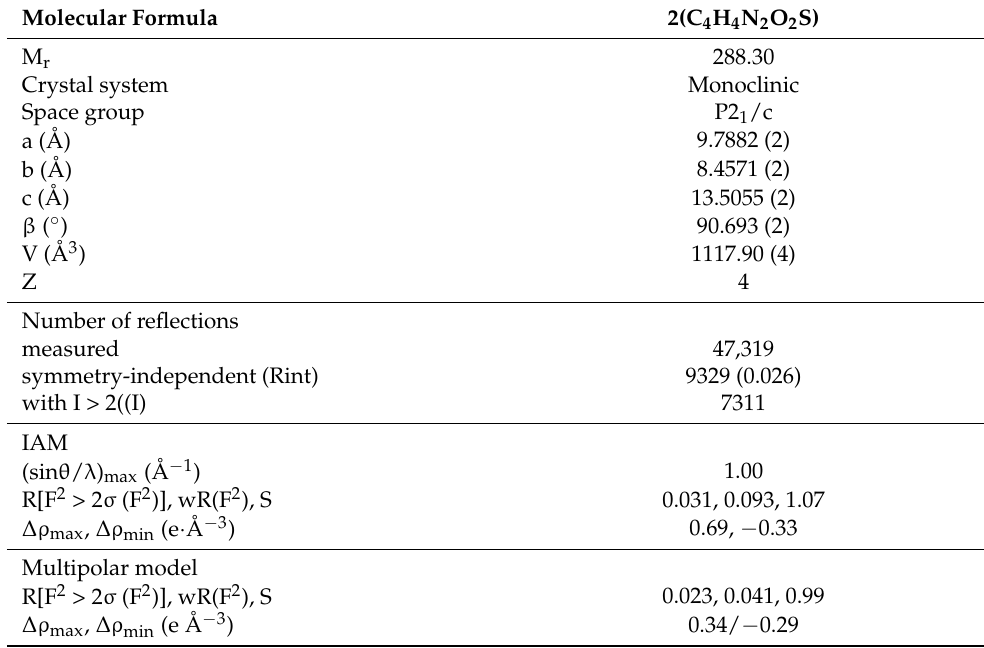
Table 1. Relevant crystallographic data and refinement